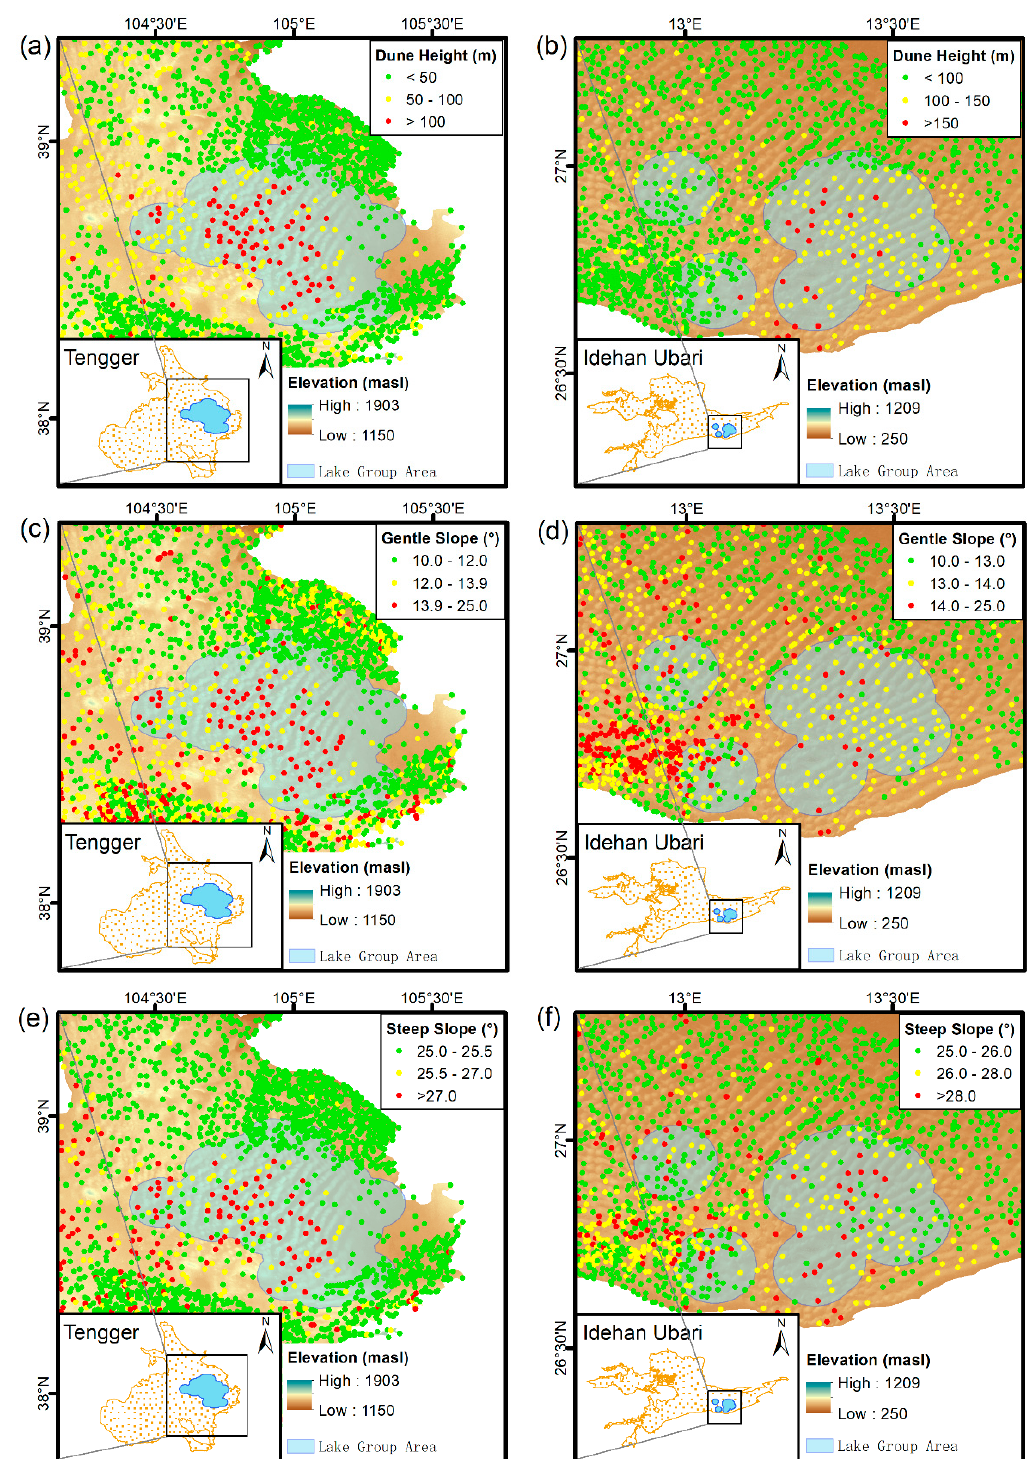
Figure 5. Spatial distribution of dune heights ( a ) gentle slopes ( c ) steep slopes ( e ) in and around the lake group area of the Tengger Sand Sea, and the spatial distribution of dune heights ( b ) gentle slopes ( d ) steep slopes ( f ) in and around the lake group area of the Idehan Ubari Sand Sea.